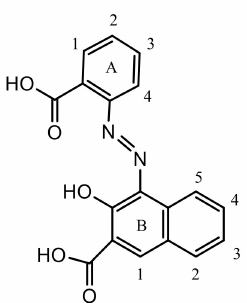
Figure 15. Structural formula of studied azo dye